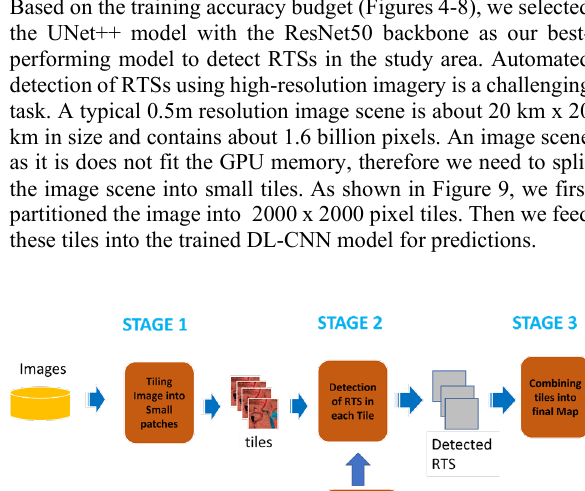
Figure 8 . F1 score for training with ResNet50(blue), ResNet101(orange) and ResNet152(green) for UNet++ network.